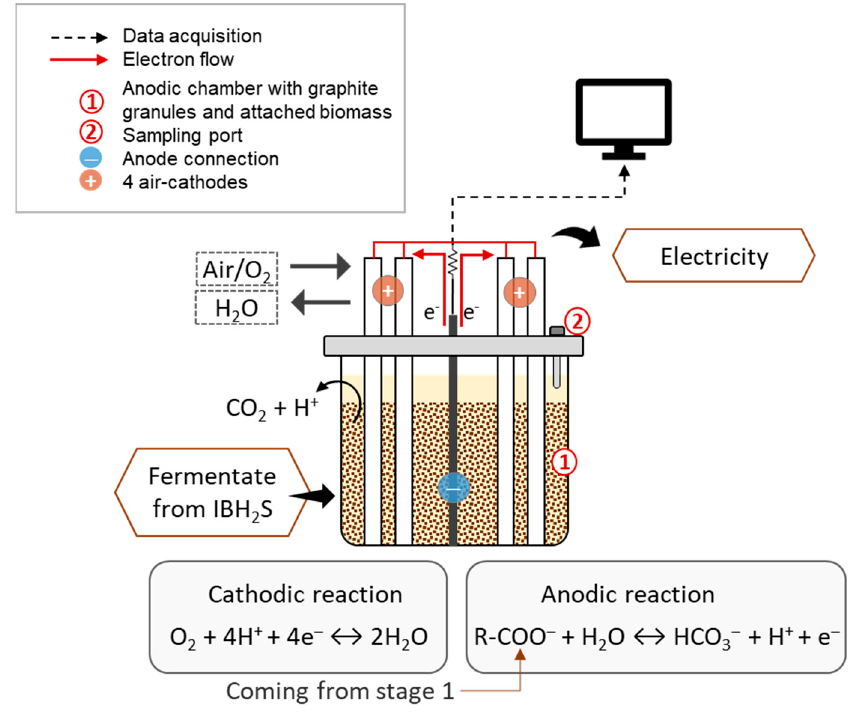
Figure 3. Single-chamber MFC layout using the fermentate from Stage 1.